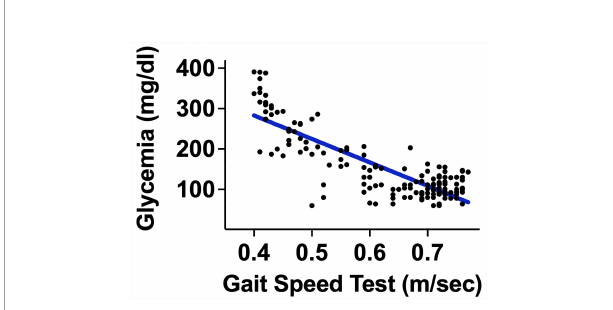
FIGURE 2 | Dispersion model correlating glycemia and 5-meter gait speed.